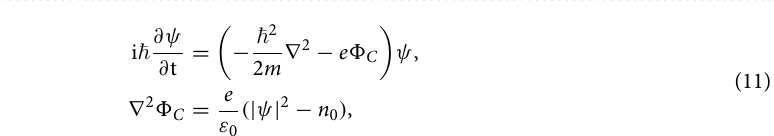
Figure 2. Superstatistical distribution functions corresponding to the χ universality classes, compared to the data of Ref. 40 (open circles), obtained from the analysis of a time series using the Complex Plasma Laboratory PK-4 instrument on-board the ISS. The left panel ( a ) shows the whole domain while the right panel ( b ) shows only the halo part, i.e, the high energy